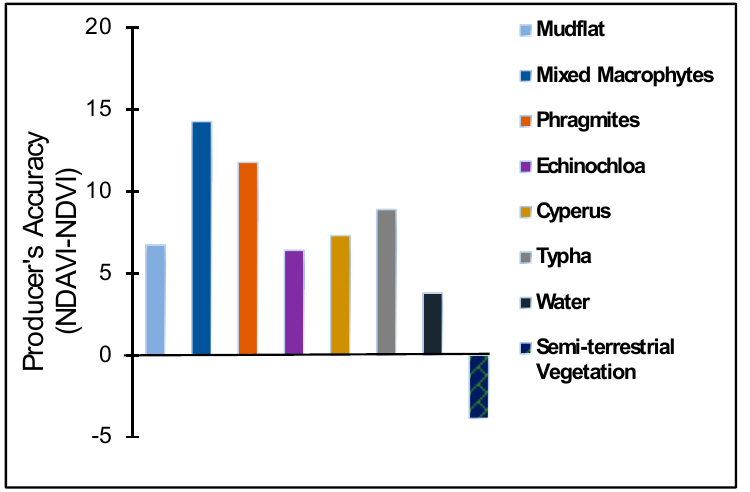
Figure 4. The producer’s accuracy difference between NDAVI based and NDVI based supervised classification for each target class.